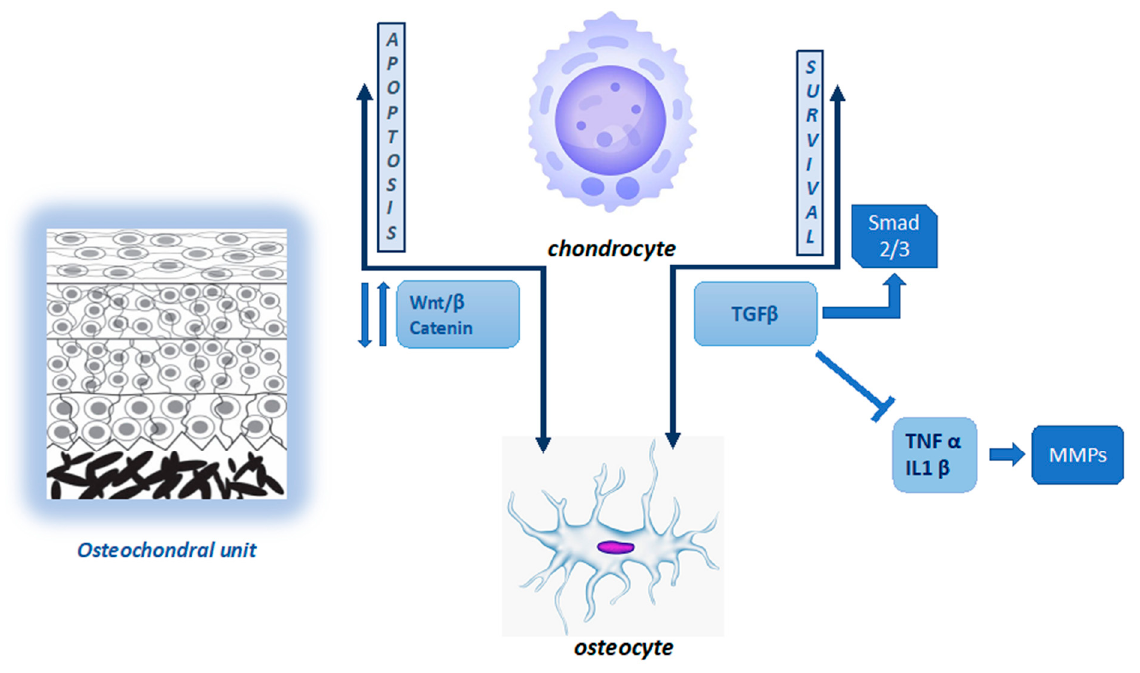
Figure 1. Cartilage–bone interaction in the osteochondral